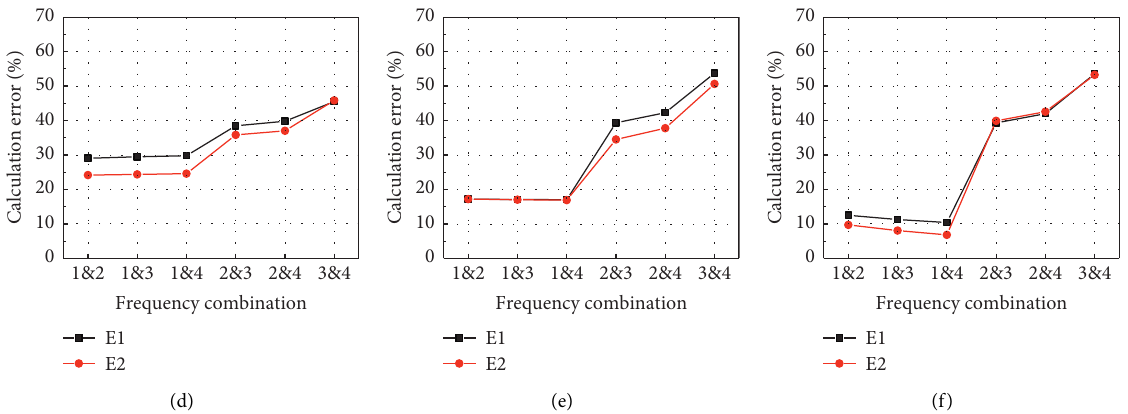
Figure 7: Calculation errors of the first story displacement by using RD (PGA � 0.2g): (a) case 221, (b) case 222, (c) case 223, (d) case 224, (e) case 225, and (f) case